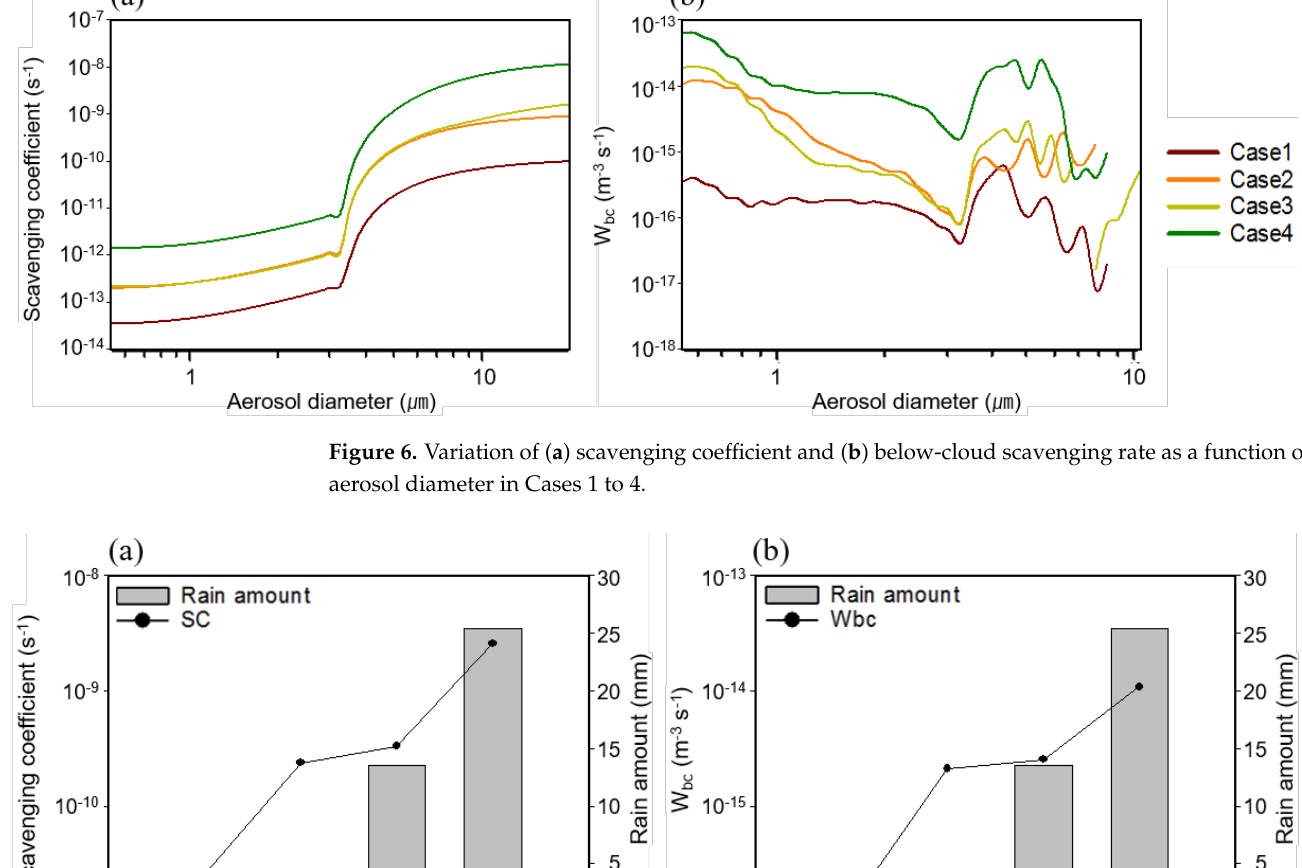
Figure 6. Variation of ( a ) scavenging coefficient and ( b ) below-cloud scavenging rate as a function of aerosol diameter in Cases 1 to 4.